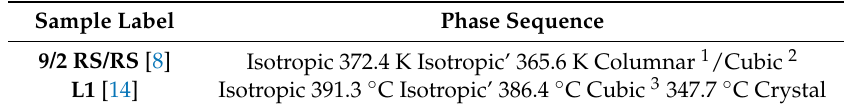
Table 1. Mesophase sequences and temperature transitions observed for the two rod-like mesogens from DSC on cooling the samples.